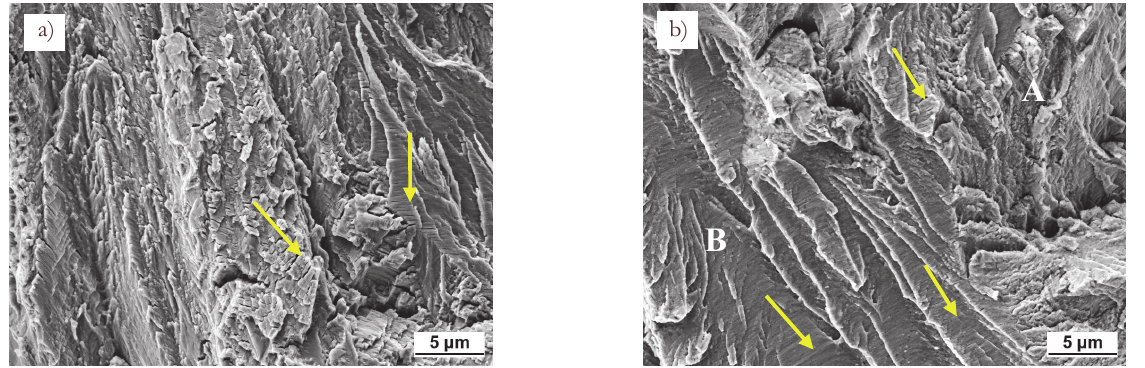
Figure 9: Fracture surface corresponding to the average crack rate 8 x 10 -7 mm/cycle